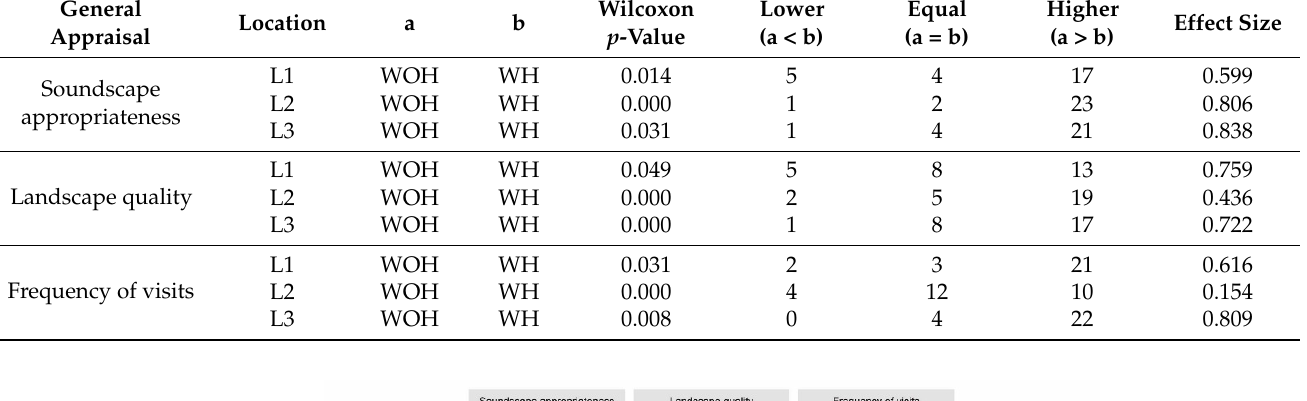
Table 4. Wilcoxon signed-rank test results ( p -value and comparison of ratings between paired variables) for the scenarios with (WH) and without helicopter noise (WOH) on the appraisals given to the soundscape appropriateness, the visual quality, and the frequency of visits. Results are shown for the locations L1 (red), L2 (green), and L3 (blue). Significant (continuous line) and non-significant differences (dashed line) between paired variables are also represented.